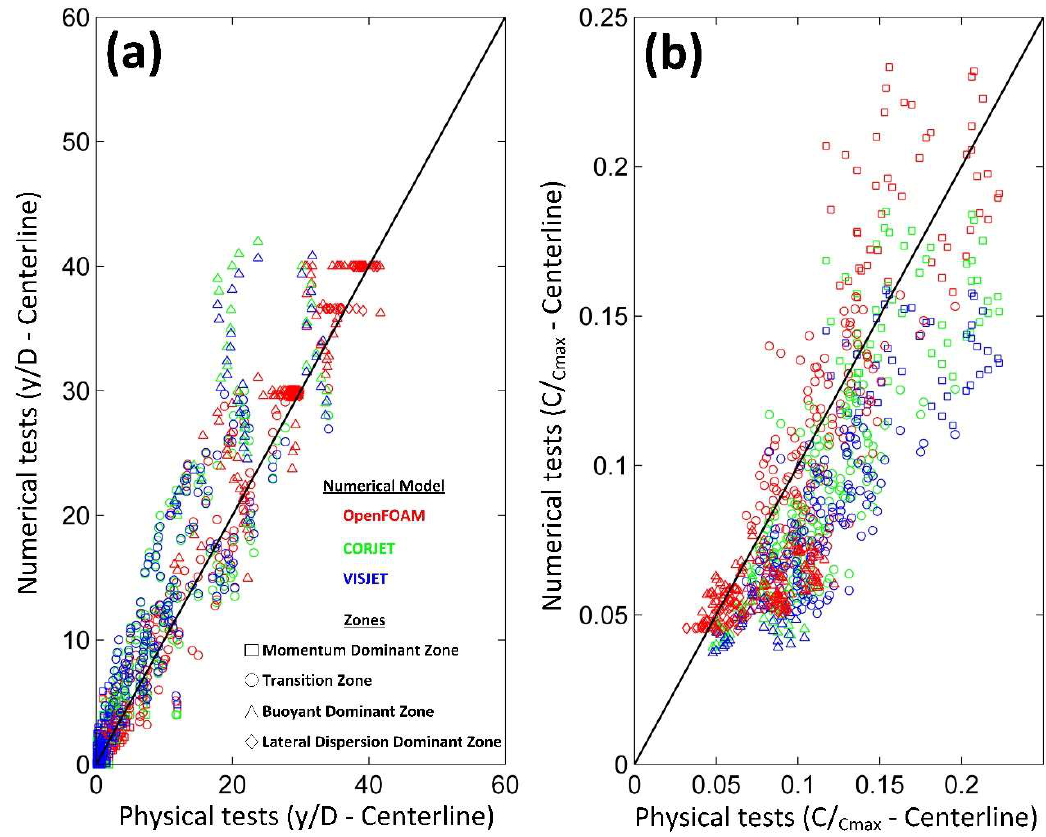
Figure 9. ( a ) Scatter plot of the centerline trajectory in dimensionless positions (X / D and Y / D). ( b ) Scatter plot of the C / C MAX along the centerline for the physical results versus the numerical results obtained with CORJET (green markers), VISJET (blue markers) and OpenFOAM (red markers) in the momentum dominant zone (square markers), the momentum to buoyancy transition zone (circle markers), the buoyancy dominant zone (triangle markers), and the lateral dispersion dominant zone (diamond markers), respectively. Table 2. Performance of the numerical models to reproduce the physical tests by the metric errors R 2 , RMSE, NRMSE, and CE.